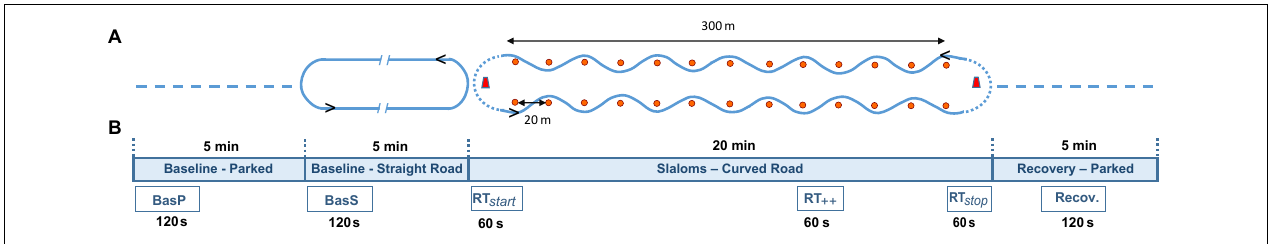
FIGURE 1 | Representation of (A) test set-up and timeline of the test session with each period: two baseline periods (parked and straight road), slaloms and recovery period; (B) the six time intervals per session analyzed for EEG signal recordings: baseline parked (BasP), baseline straight road (BasS), slaloms (comprising RT start , RT ++ , RT stop ) and recovery (Recov); see section “Data Acquisition and Processing”.